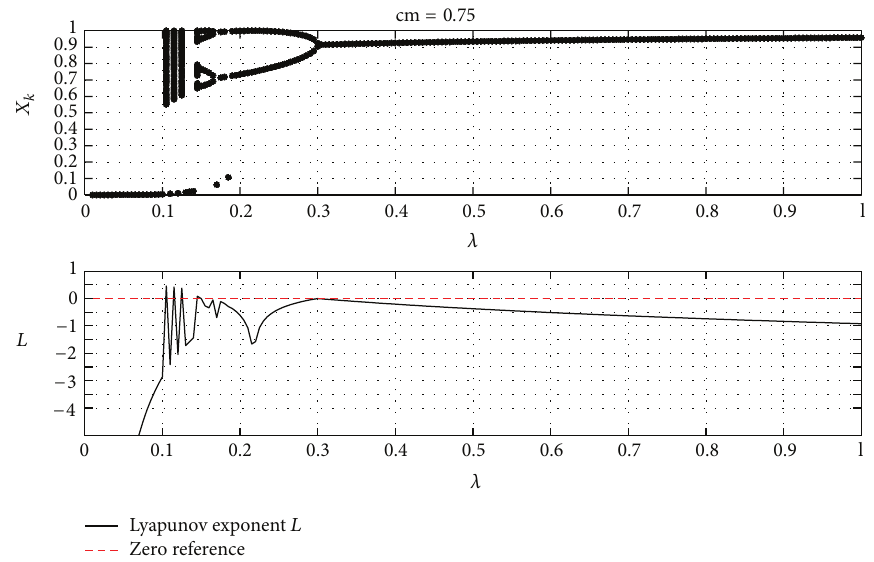
Figure 8: A bifurcation diagram and Lyapunov exponent setting cm = 0.75 .